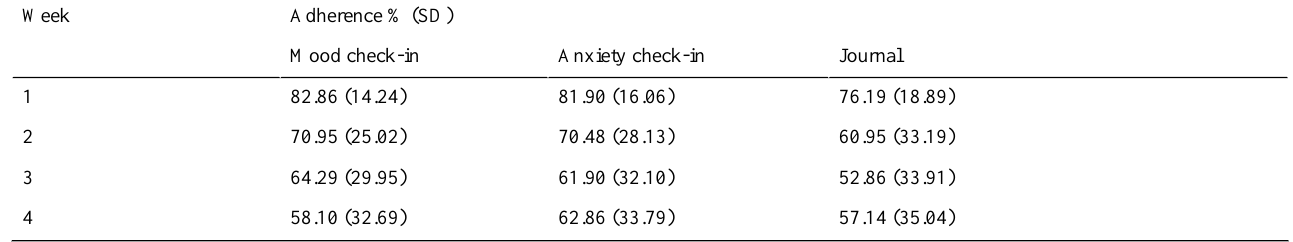
Table 2. Weekly adherence rates for in-app mood and anxiety Likert scales and journaling.